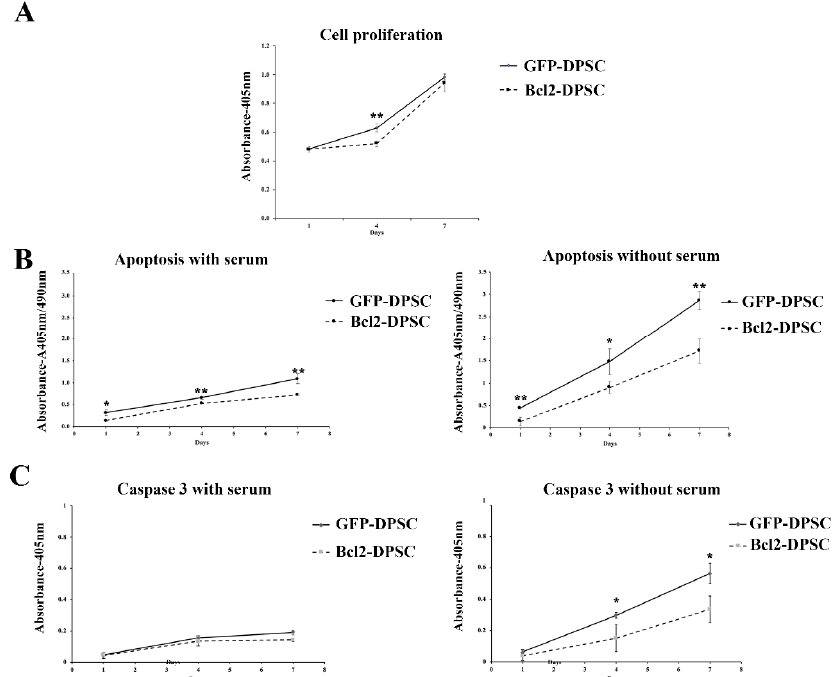
Figure 2. Characterization of Bcl-2-DPSCs. ( A ) Cell proliferation rates of Bcl-2-DPSCs and GFP-DPSCs as shown by Cell Counting Kit-8 (CCK-8) assay. Except at day 4, no significant di ff erence was observed between the two groups. ( B ) Apoptosis in cultures of Bcl-2-DPSCs and GFP-DPSCs in the presence and absence of serum. Bcl-2-DPSCs demonstrated significantly lower apoptotic levels compared to GFP-DPSCs at all the time points under both conditions. Under serum starvation, the di ff erence was markedly increased. ( C ) Caspase-3 activity in Bcl-2-DPSCs and GFP-DPSCs in the presence and absence of serum. Caspase-3 levels were significantly lower in Bcl-2-DPSCs in serum-free condition compared to that of GFP-DPSCs. * p < 0.05, ** p < 0.01versus the corresponding